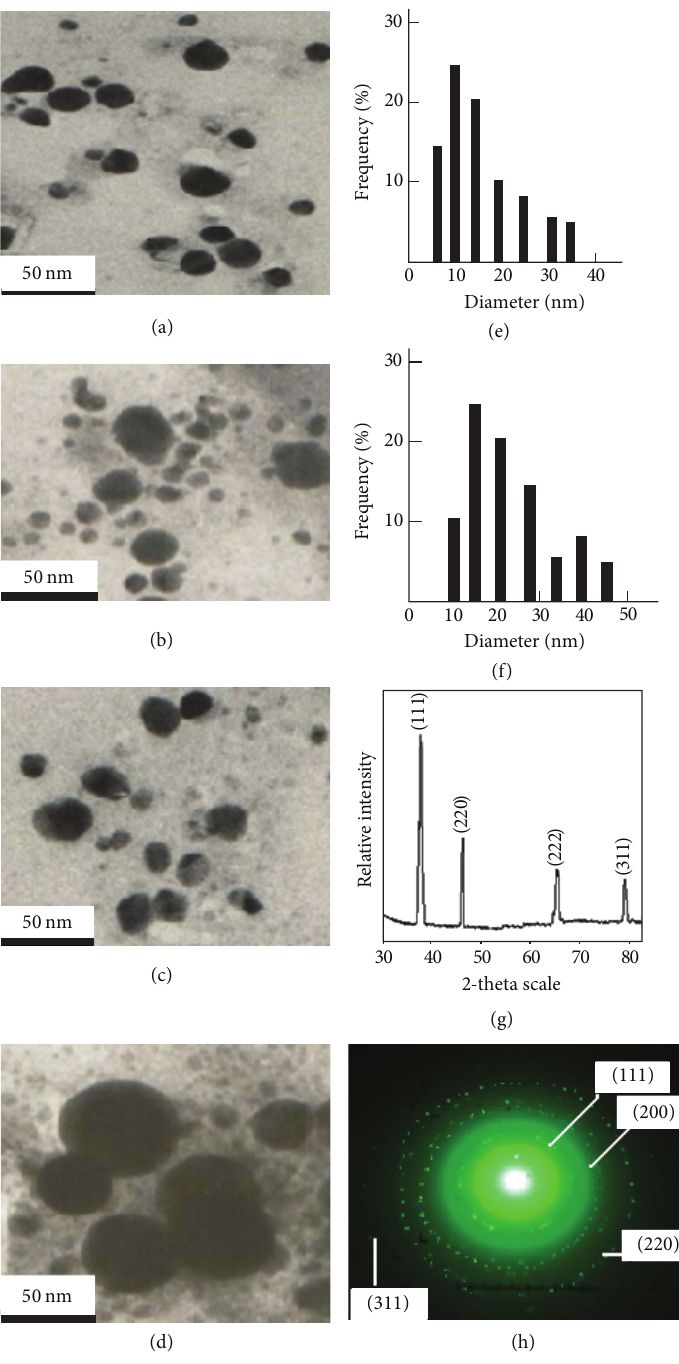
Figure 2: (a, e) TEM image and size distribution of S 5 , (b, f) TEM image and size distribution of S 4 , (c) TEM image of S 3 , (d) TEM image of S 2 , and (g) P-XRD pattern of S 5 and SAED pattern of S 5 .